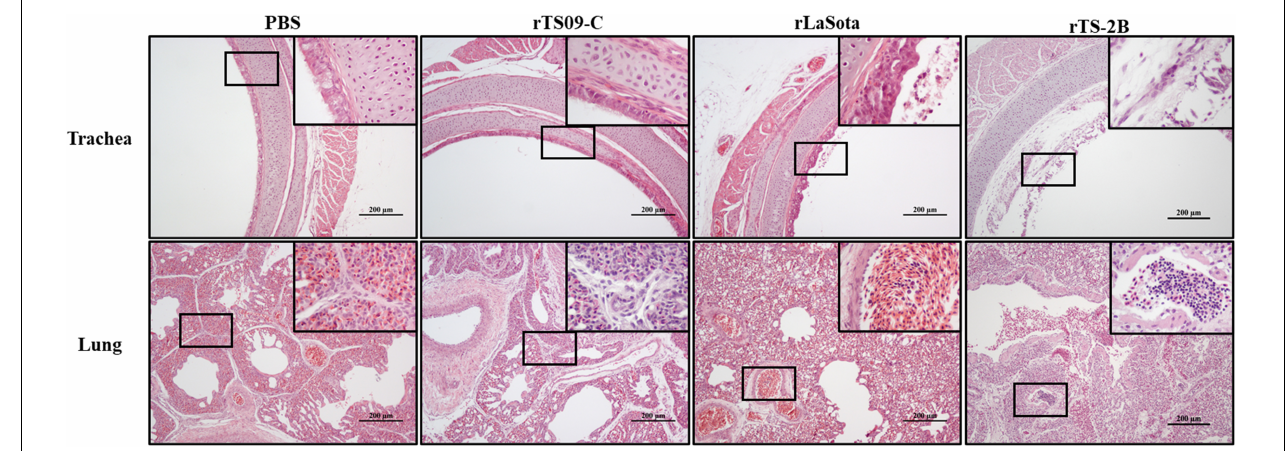
FIGURE 5 | Histopathological analysis of tissue samples from SPF chickens vaccinated in ovo with different NDVs. SPF chicken embryos were inoculated with NDVs rLaSota, rTS09-C, or rTS-2B or PBS. Lung and tracheal samples were collected from the in ovo vaccinated birds at 4 dpi, fixed in 4% paraformaldehyde, paraffin embedded, sectioned, stained with hematoxylin–eosin, and analyzed microscopically. Scale bar = 200 µ m.